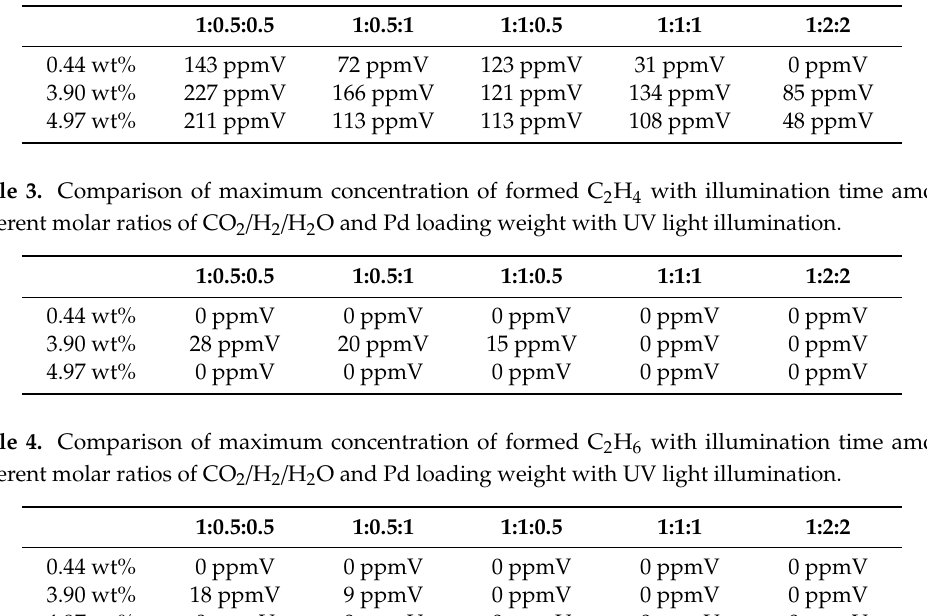
Table 2. Comparison of maximum concentration of formed CH 4 with illumination time among di ff erent molar ratios of CO 2 / H 2 / H 2 O and Pd loading weight with UV light illumination.